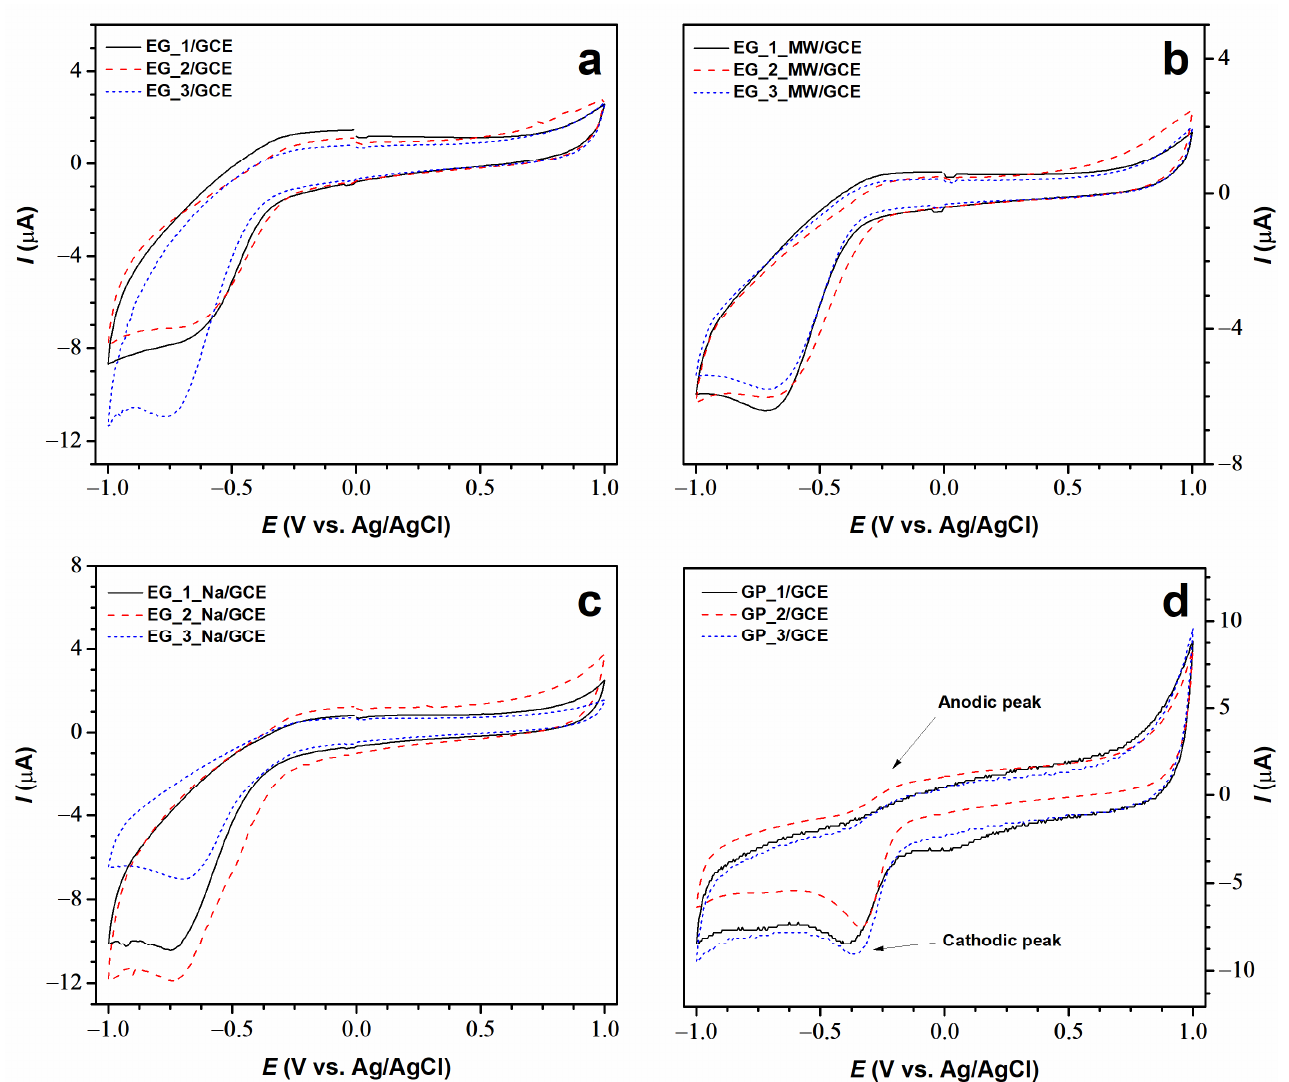
Figure 7. CVs of EG/GCE ( a ), EG_MW/GCE ( b ), EG_Na/GCE ( c ) and GP/GCE ( d ) samples.